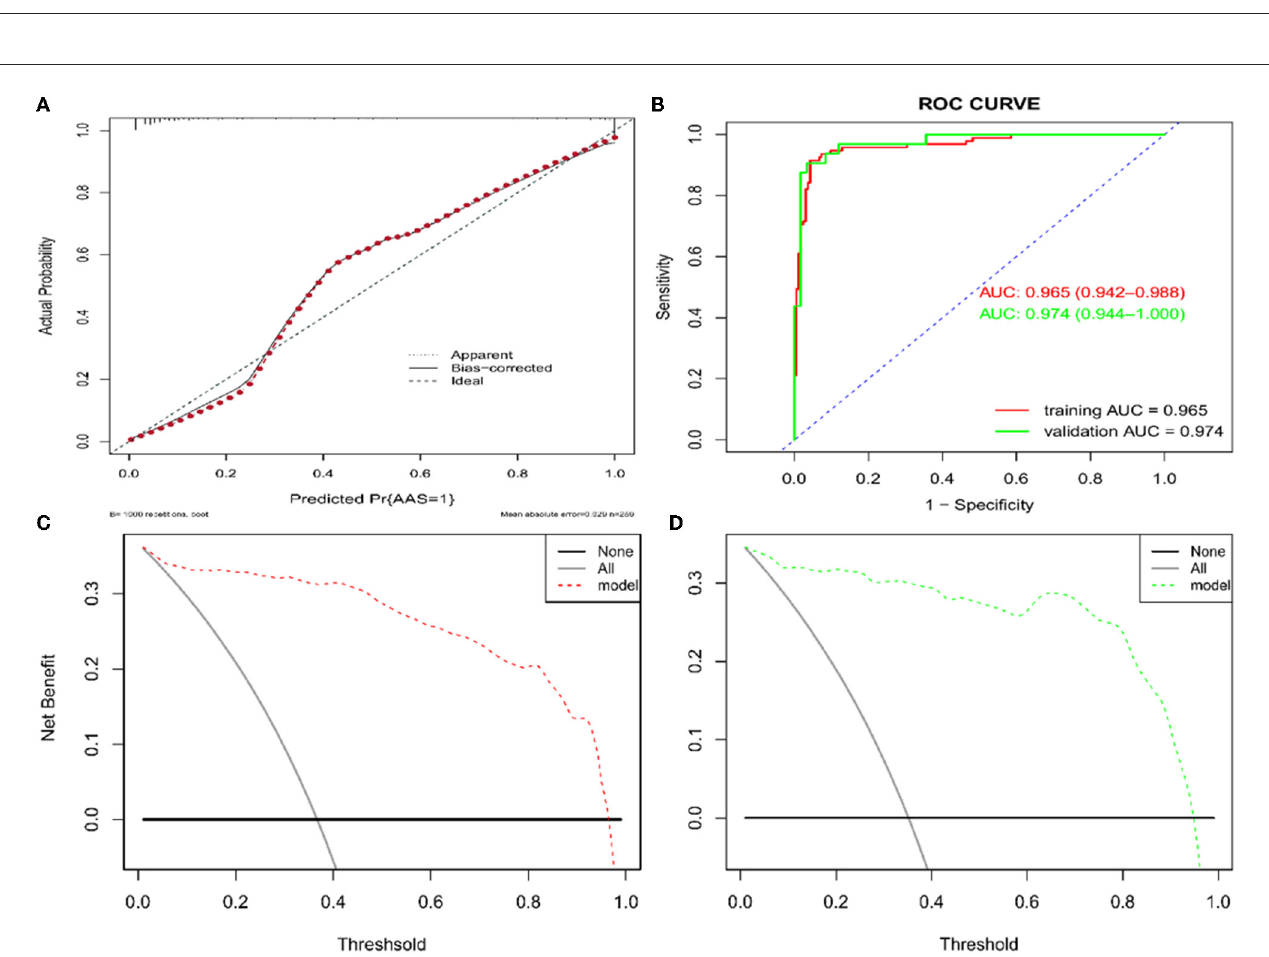
FIGURE5 Assessment and validation of the nomogram model. (A) Calibration plot in the training set. (B) ROC curves in both the training and validation sets. (C) Decision curve in the training set. (D) Decision curve in the validation set. AUC, areas under the curve; ROC, receiver operating